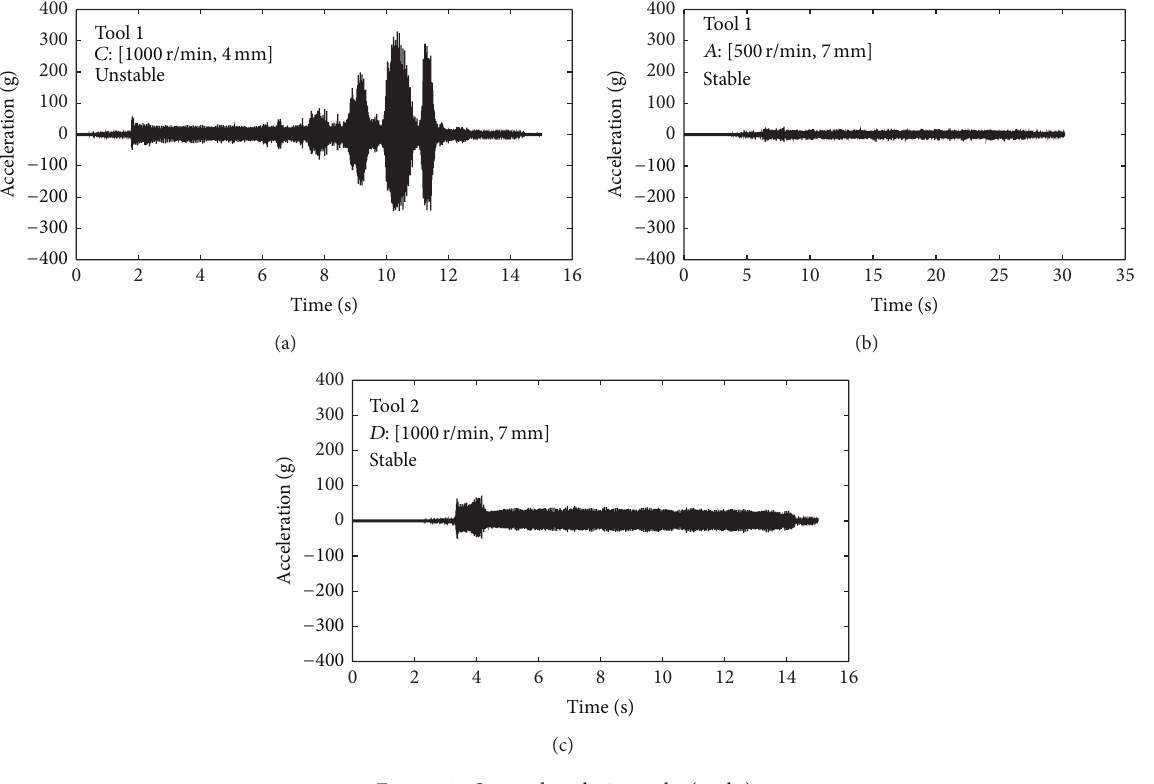
Figure 11: Spectral analysis results (tool 1).